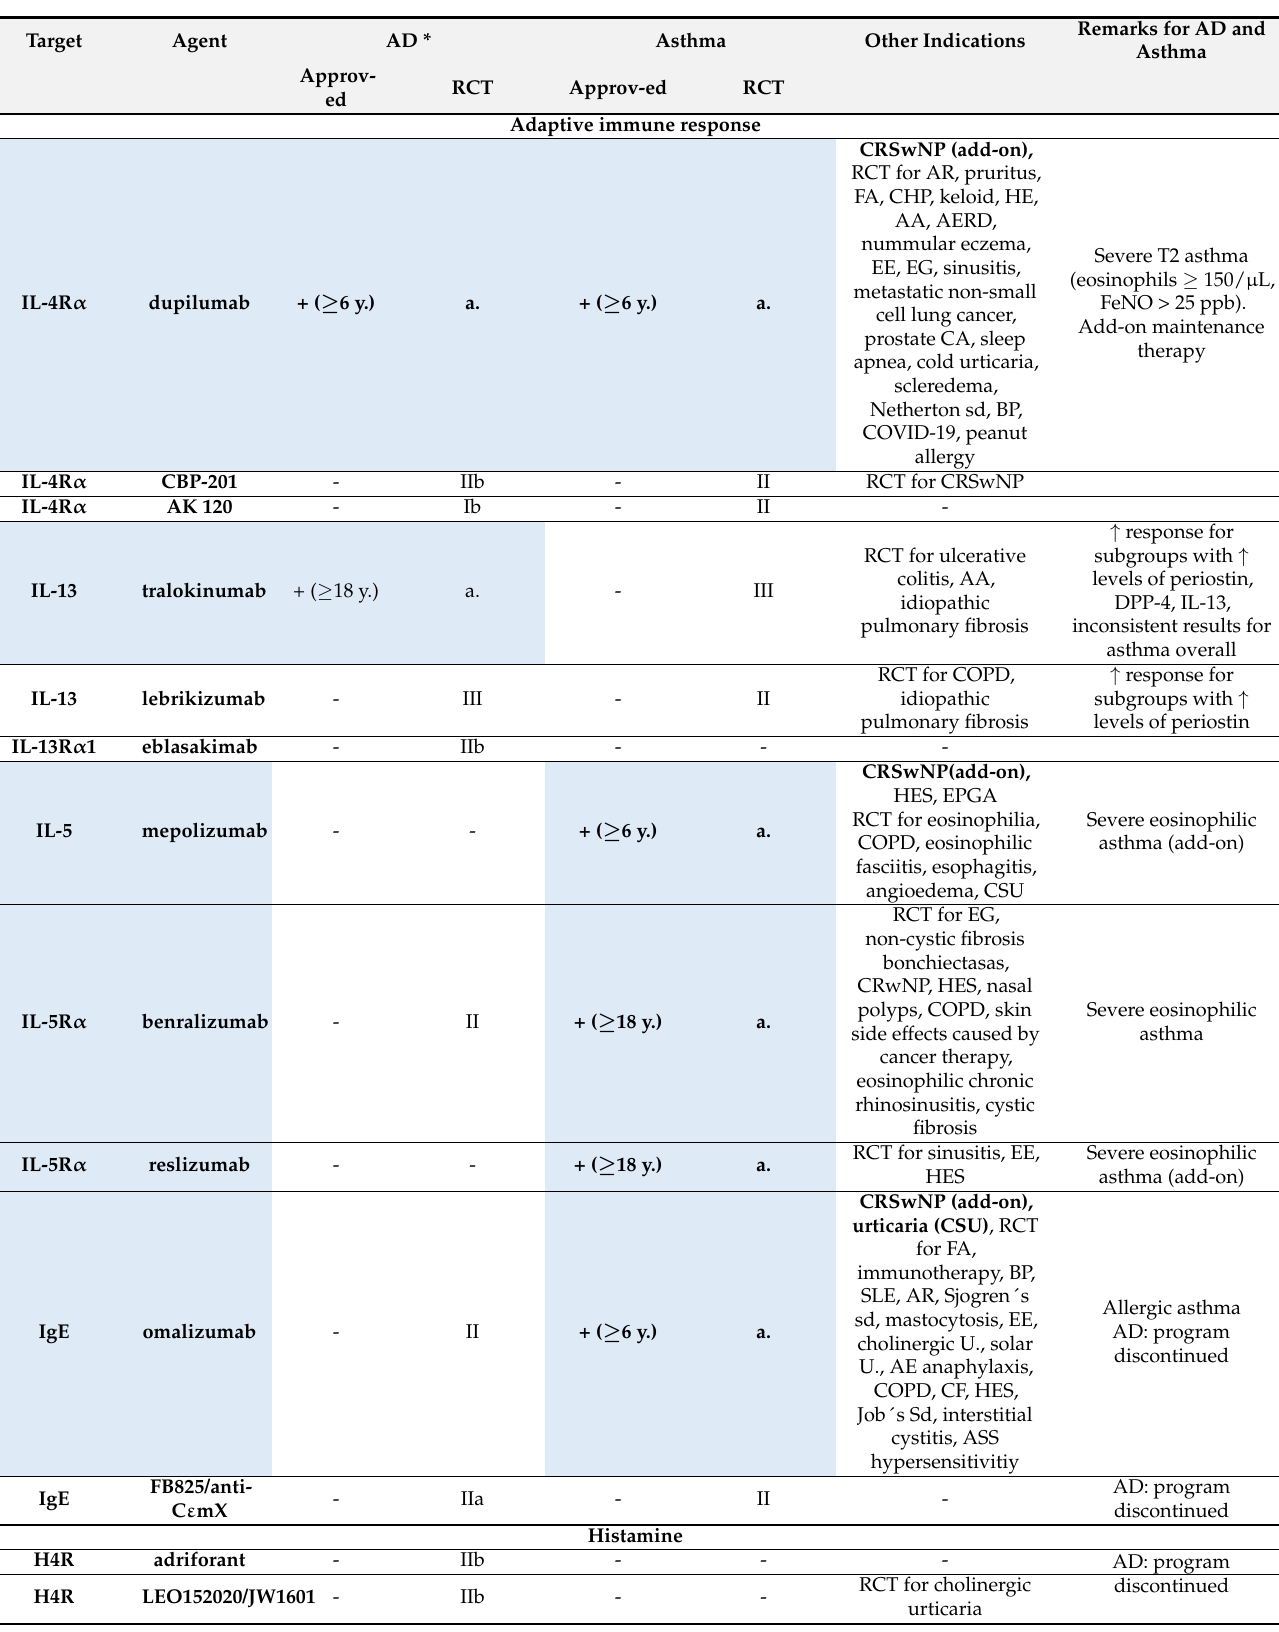
Table 1. Overview of systemic targeted therapies approved or in clinical trials for atopic dermatitis (AD) and/or